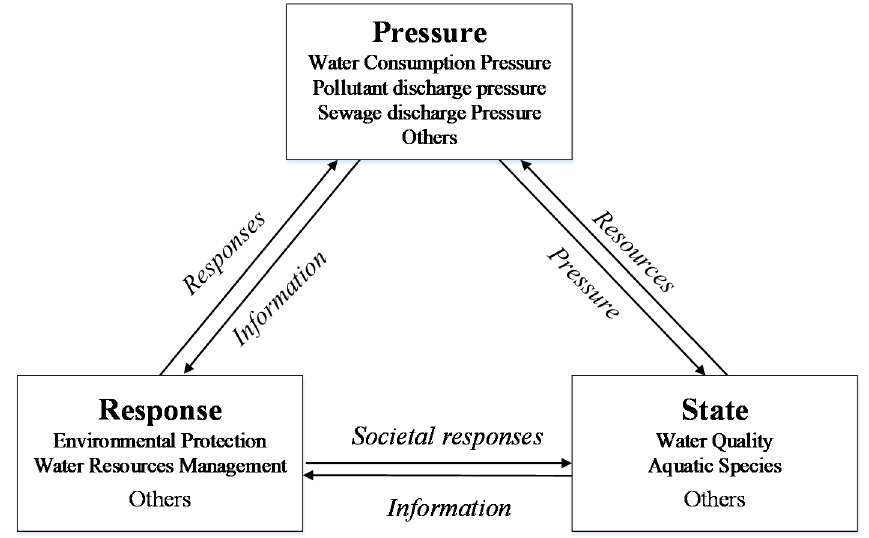
Figure 2. The pressure–state–response (PSR) framework to assess urban river health.